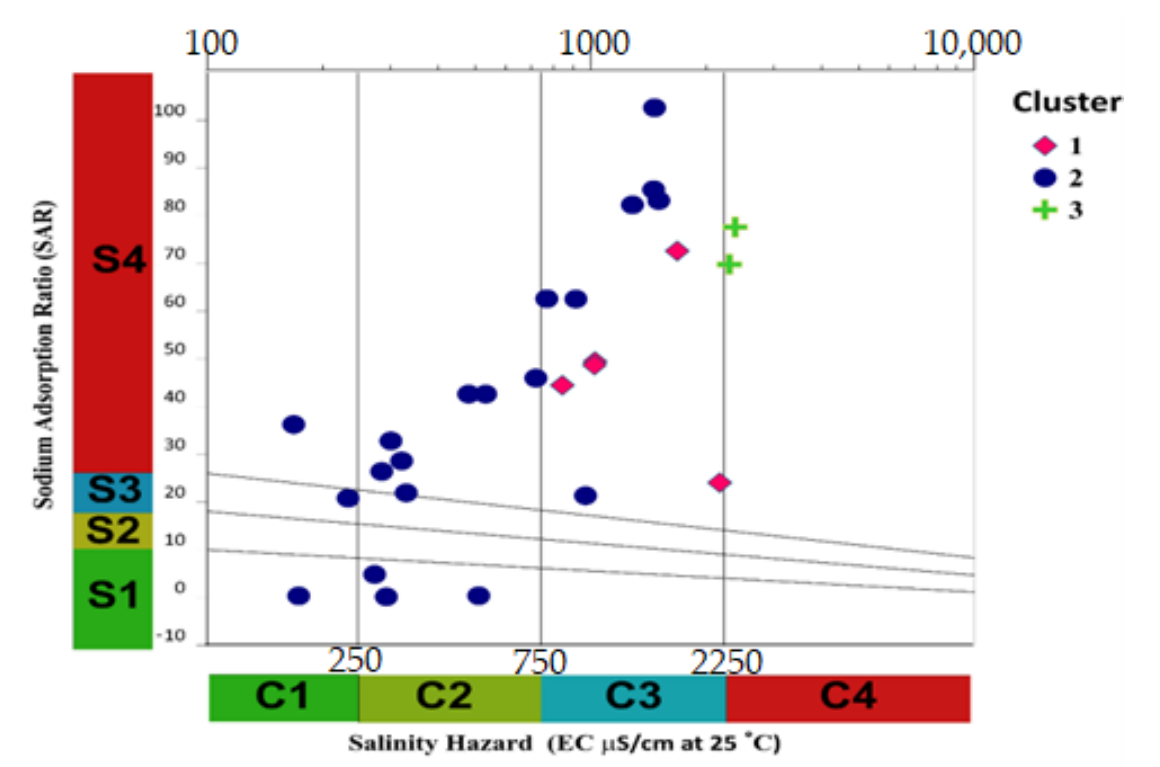
Figure 2. Irrigation water quality of estimated based on: Piper diagram.